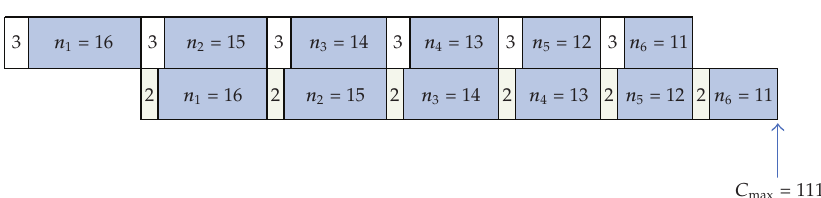
Figure 3: Optimal schedule of a 2-machine flowshop (cid:5) Example A.1: n (cid:8) 80 ,s 1 > s 2 ,s 1 (cid:8) 3 ,s 2 (cid:8) 2 (cid:6)